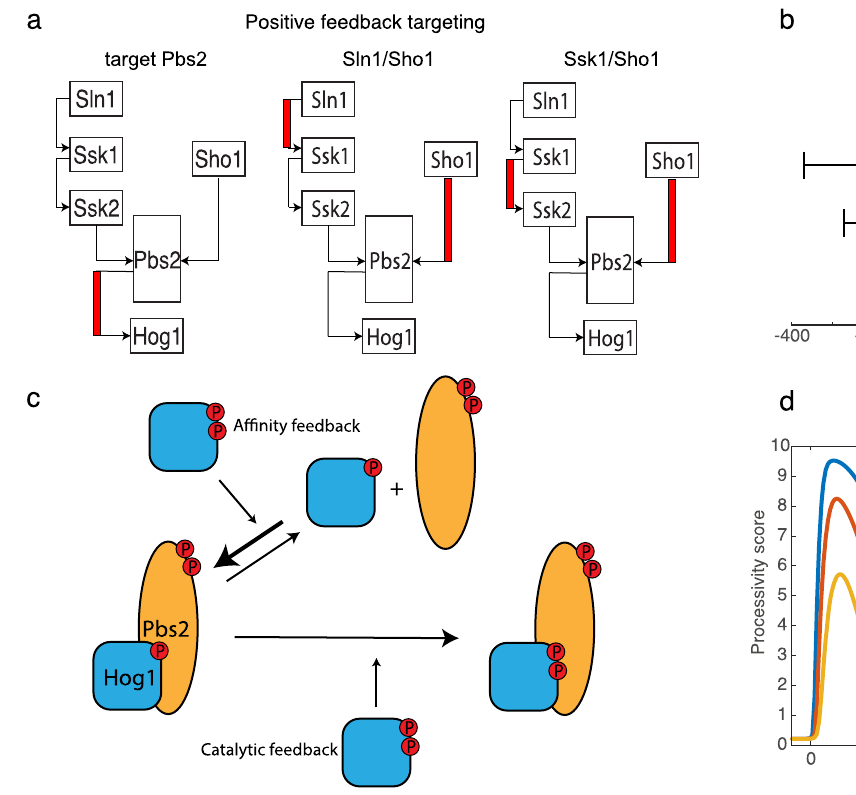
Fig. 4 | Two-component positive feedback to Pbs2 gives best goodness of fi t andresultsinincreaseofprocessivity.a Schematicofthreemodelswithpotential targets for positive feedback upstream of Hog1, showing the positive feedback highlighted in red for models where activated Hog1 phosphorylates either Pbs2 (left),Sln1andSho1(middle),orSsk1orSho1(right). b Akaikeinformationcriterion (AIC) was used to order optimized models with the indicated positive feedback targets, in which all models include negative feedback and a mixed Hog1 phos- phorylationmechanism.PositivefeedbacktargetingPbs2achievesbestAICamong other putative targets. c Positive feedback of activated Hog1 to Pbs2 results in an